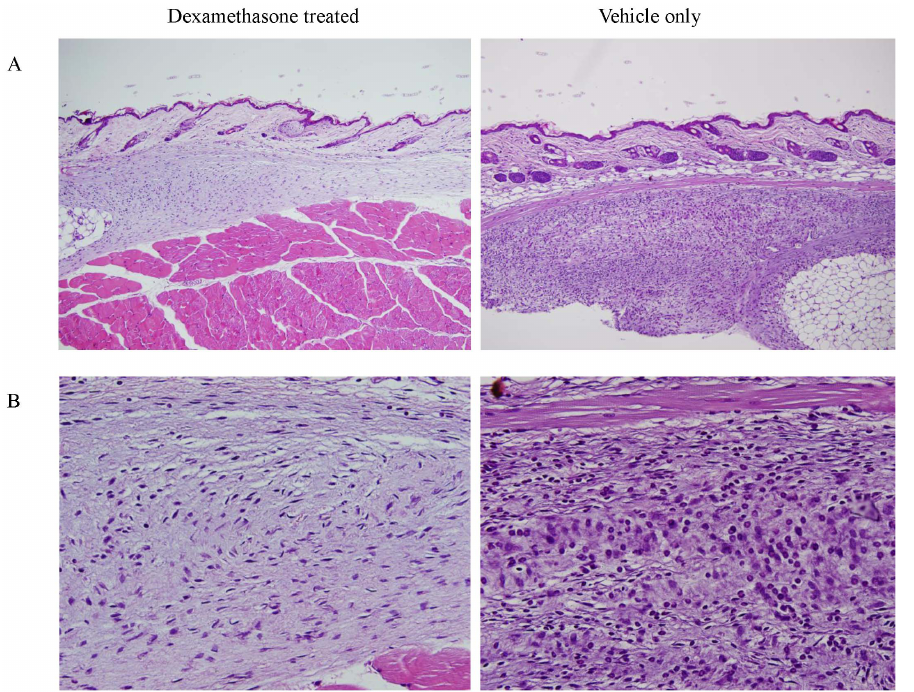
Figure 9. H and E staining show histologic features on midge-sensitized mice treated with dexamethasone ointment or with carbomer alone. Magnification: A, 6 100; B, 6